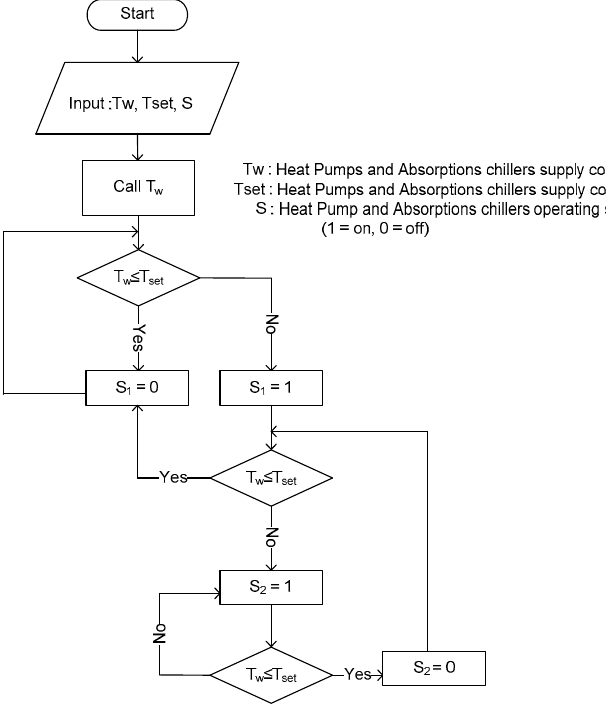
Figure 3. Control methods for an existing GHP.